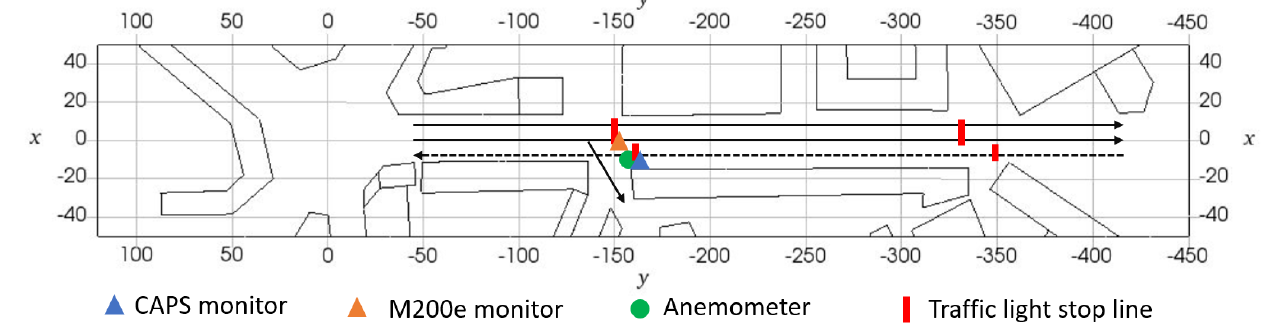
Figure 3. Location of monitors along London Road for the field study. The black arrows indicate lanes of traffic. The dashed line indicates a bus lane. Dimensions are shown in